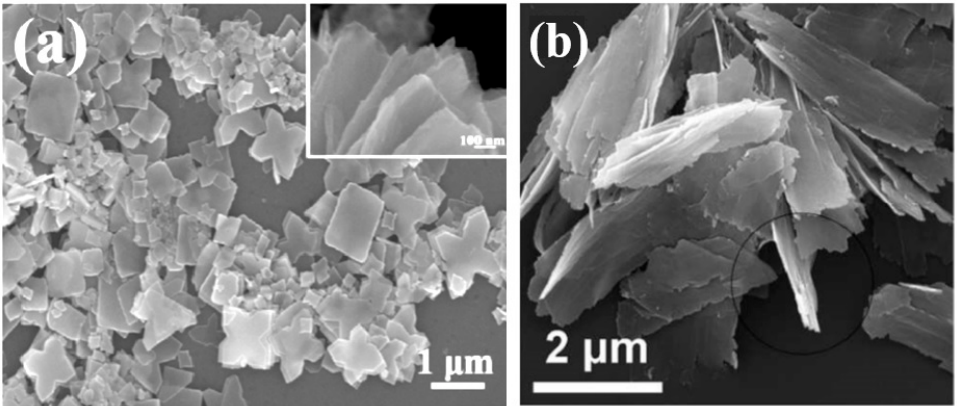
Figure 41. Low and high magnification (inset) FESEM images of WO 3 ( a ) and Co 3 O 4 nanosheets ( b ). Nanosheets were synthesized via a hydrothermal method. The thickness of nanosheets was from 20 to 30 nm for WO 3 and from 20 to 50 nm for Co 3 O 4 nanosheets. (a) Reproduced with permission from Wang et al. [368]. Copyright 2017: Elsevier; (b) reproduced with permission from Wang et al.